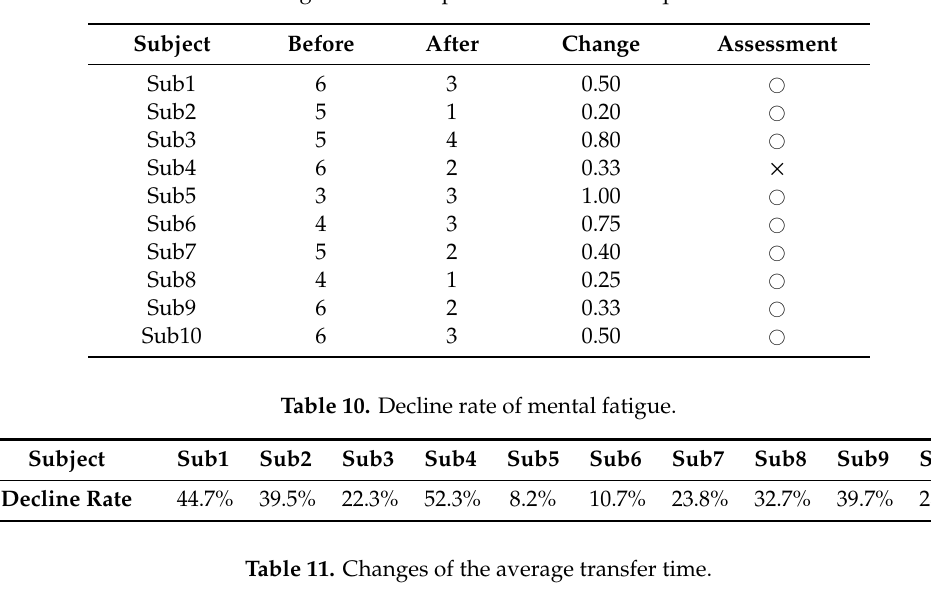
Table 9. Changes of the acceptance level from the questionnaire.